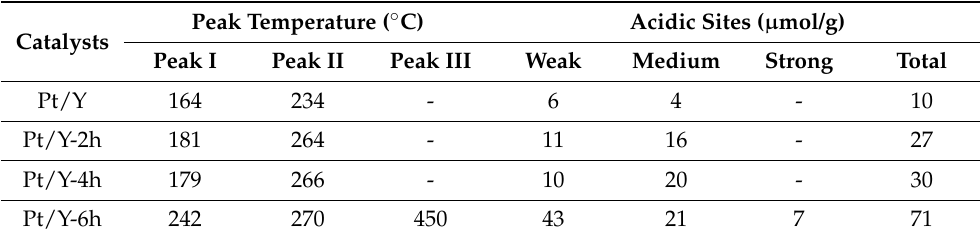
Figure 5. Temperature-programmed desorption of ammonia curves of the Pt/Y zeolites. Table 3. Acidic sites and peak temperatures of the Pt/Y zeolites.